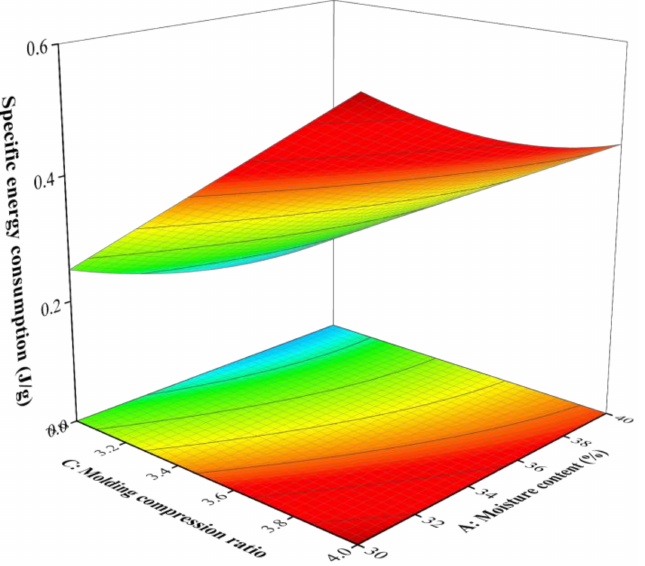
Figure 5. Interaction effect of moisture content and molding compression ratio on specific energy consumption with the binder mass fraction of 3% and strain maintenance time of 60